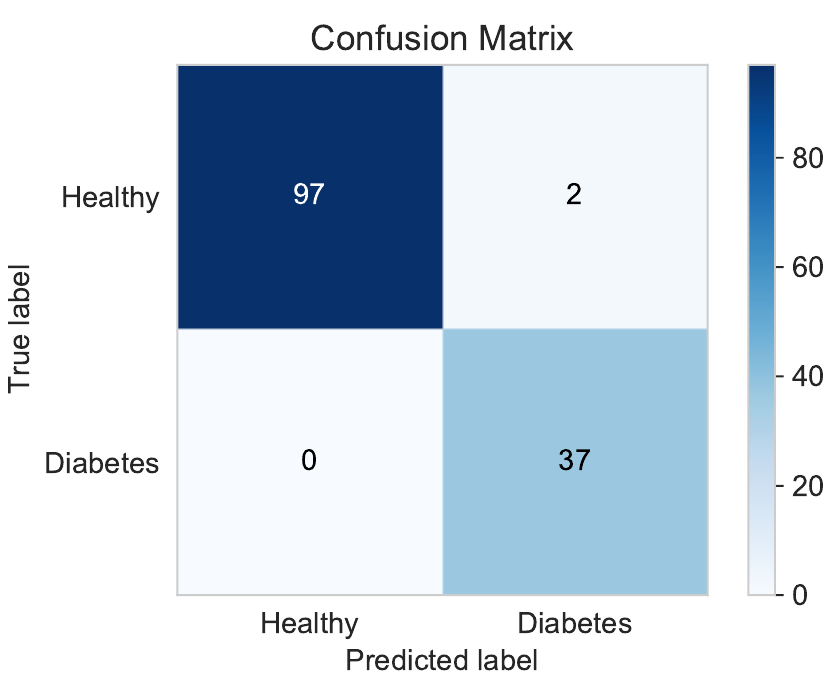
Figure 12. XGBoost Classifier confusion matrix.